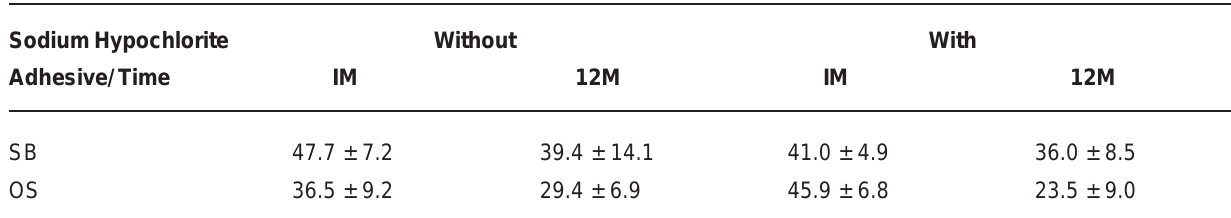
TABLE 2- Bond strength means (MPa) and standard deviation for adhesive systems applied conventionally or after deproteinization